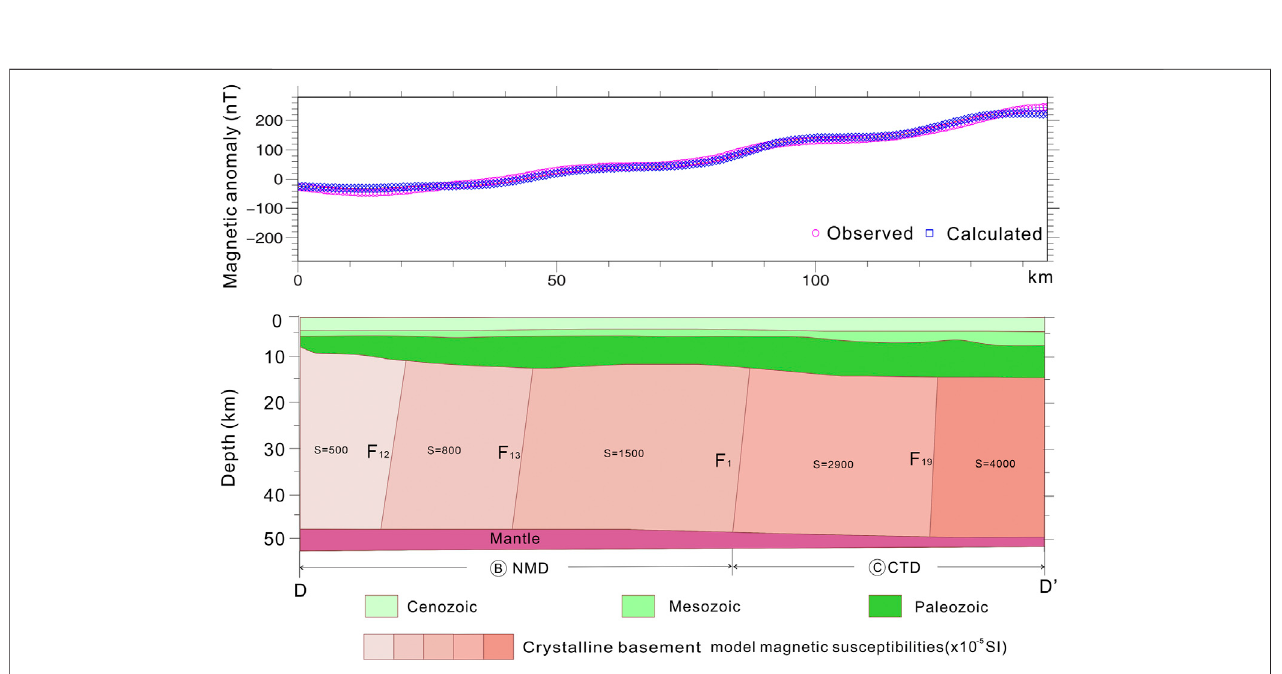
FIGURE 10 | Pro fi le DD ′ for magnetic forward modeling, pro fi le location showed in Figure 2A . See Figure 7 for other fi gure descriptions.